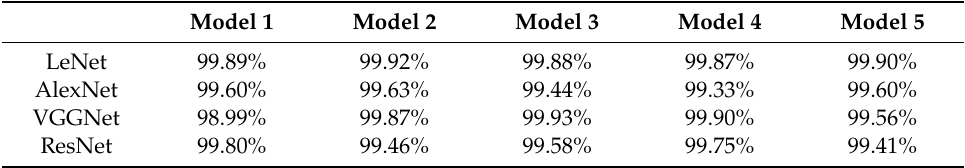
Table 3. Test accuracy of four convolution neural